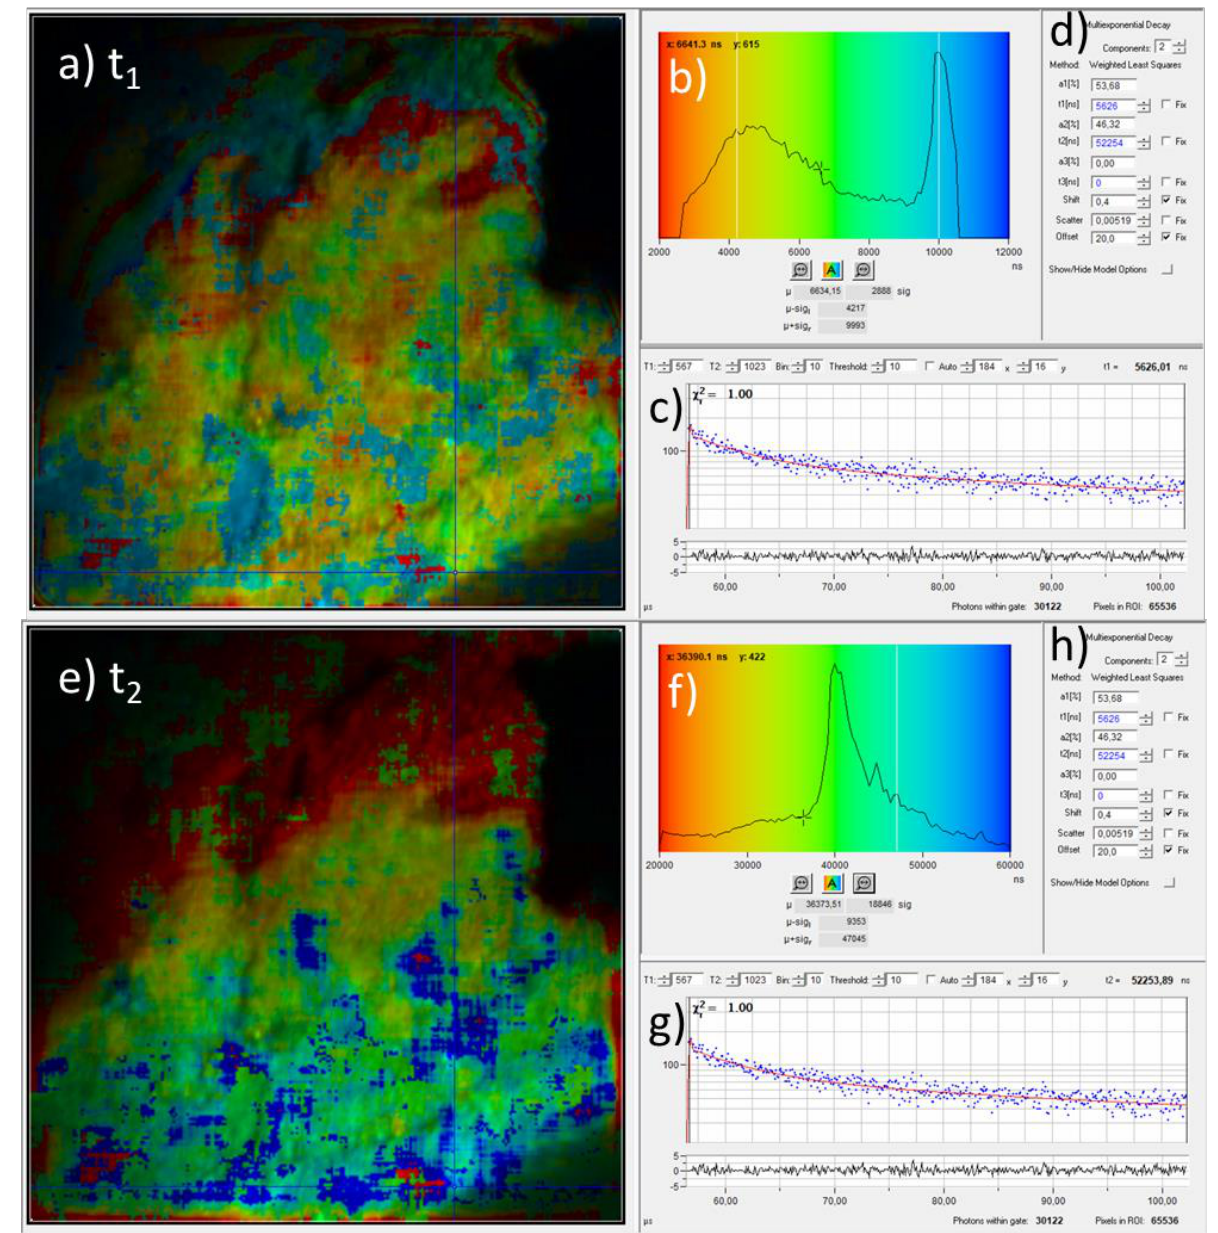
Figure 4. Phosphorescence lifetime imaging and decay time analysis by bi-exponential fitting of the time-resolved phosphoresce signal. ( a ) PLIM image where the pixel colors represent the value of the fast decay time component t1 which was obtained by pixelwise fitting the time-resolved phosphorescence data. The colors cover values from 2 µs to 12 µs as indicated by the background colors of the histogram in (b). The image shows a region of 100 µm × 100 µm. ( b ) Color legend and pixel frequency histogram of the fast decay time values. ( c ) Phosphoresce decay data (blue dots) and fit curve (red line) at the position which is indicated by blue crossing lines in (a). ( d ) Fit parameters which correspond to the fit curve in (c). ( e ) – ( g ) Corresponding results for the slow decay component t2. ( h ) Fit parameters which correspond to the fit curve in (g).